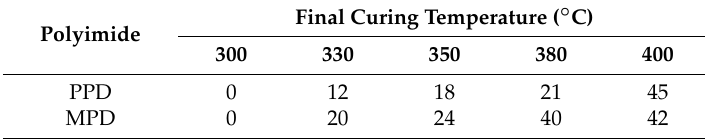
Table 2. Degree of crosslinking ( D C , %) of the PI films cured at different temperatures.